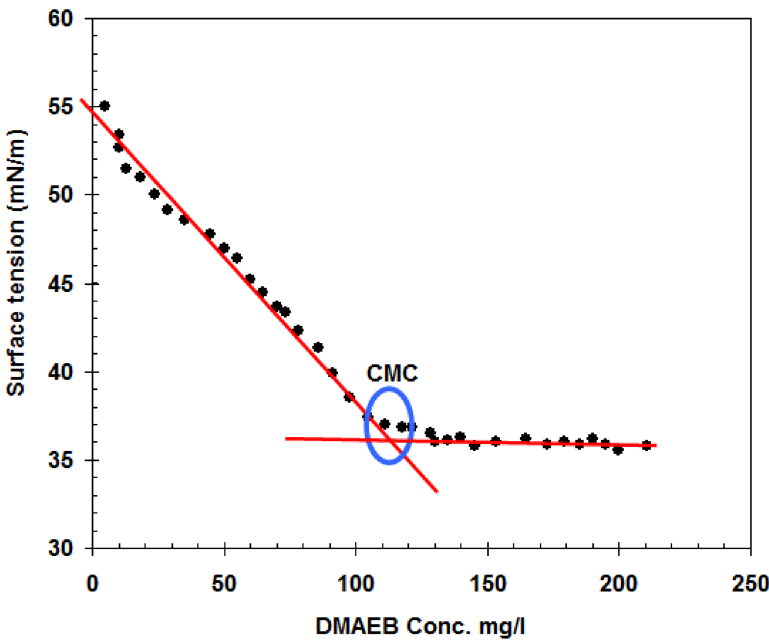
Figure 2. Variation of the surface tension with concentrations of DMAEB at 303